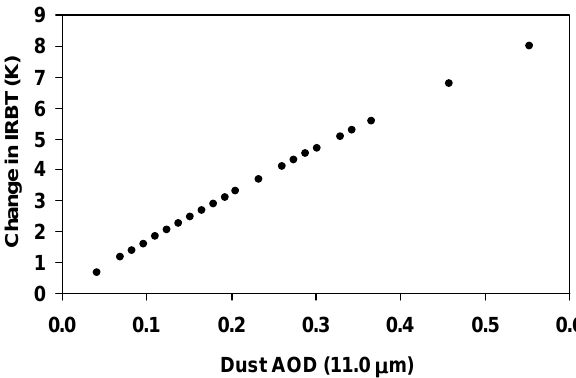
Fig. 12. Change in IRBT as a function of dust optical depth at 11 µ m. Here, dust aerosol model of Hess et al. (1998) was used.